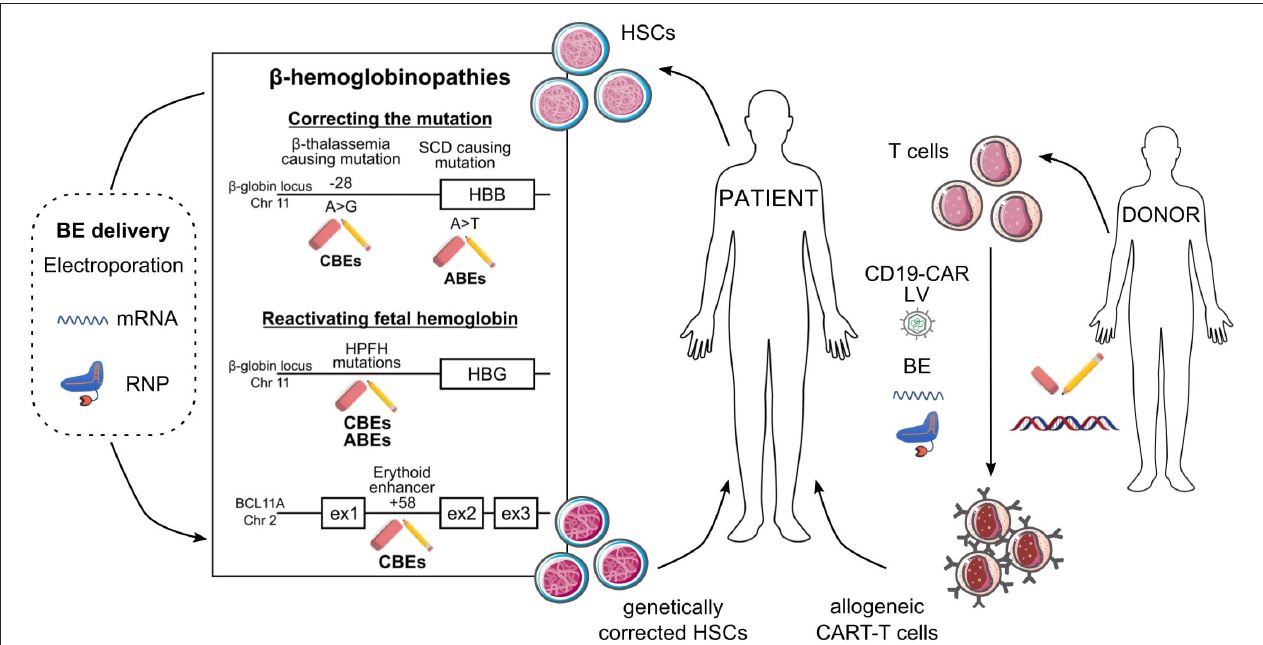
FIGURE 2 | Potential ex vivo base editing approaches for genetic blood disorders. Schematic representation of base editing approaches to genetically correct HSCs from SCD and β -thalassemia patients (left) or to generate allogeneic CAR-T cells (right). (Left) Correction of the A > G β -thalassemic mutation (in position-28) and reversion of the SCD A > T mutation can be performed using CBEs and ABEs, respectively. HbF reactivation can be achieved (i) upon generation of HPFH mutations in HBG1/2 promoters by ABEs or CBEs or (ii) upon disruption of the BCL11A erythroid enhancer (located at position + 58kb from BCL11A transcription start site) by CBEs. BEs are delivered to HSCs as mRNA or RNP complexes. In ex vivo gene therapy approaches, HSCs genetically modified by BEs will be transplanted to the patient as a definitive therapy. (Right) Multiplex base editing of loci involved in alloreactivity (e.g., TRAC , B2M , PDC1D , CD7 ) and lentiviral vectors (LV)-mediated CAR expression to safely generate allogeneic CAR-T cells, which will be infused into patients to kill cancer